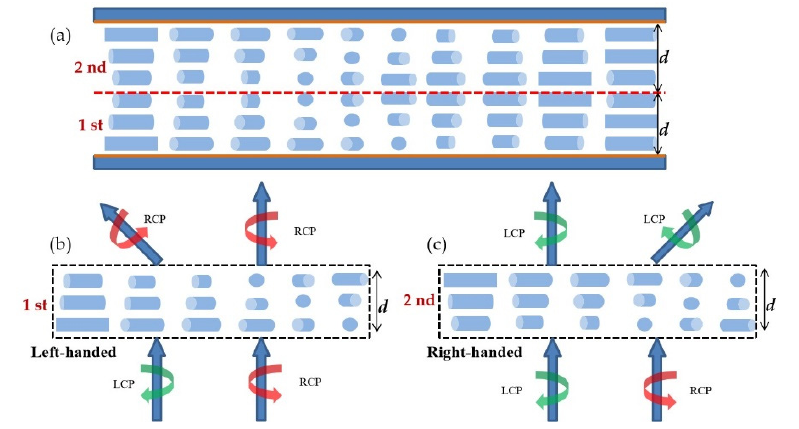
Figure 16. ( a ) Illustration of antisymmetric dual-twist structure. The schematic of optical performance when LCP/RCP is input to the 1st ( b ) and the 2nd ( c ).